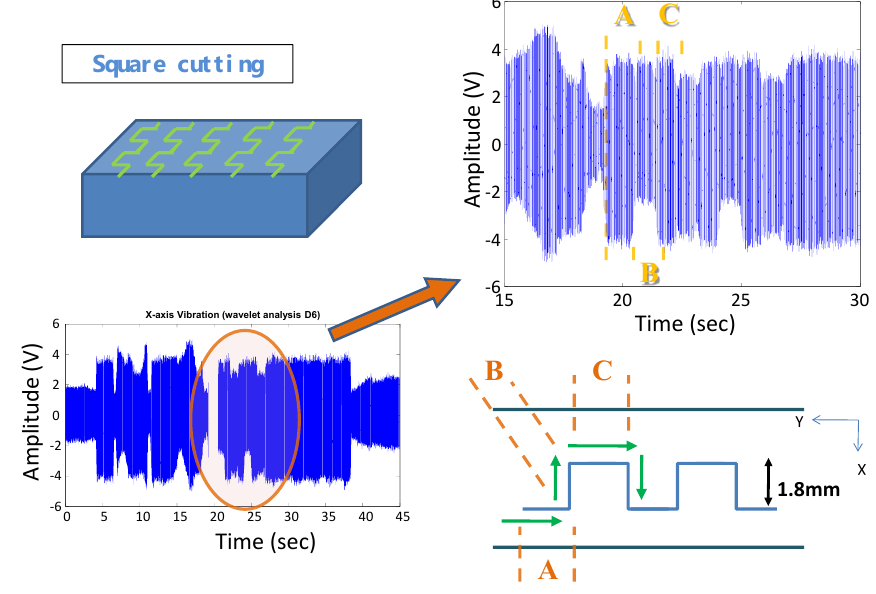
Figure 9. Signal change in square path cutting (sharp tool in x − direction). The AE signals are generated primarily by the strain rate of the material on the work- piece and the tool, as well as the friction on the tool—chip interface. The raw signal of the AE signals collected simultaneously with the vibration signals are shown in Figure 10 for the sharp and worn tool. In contrast with the vibration signal discussed above, no clear energy change in the signal features can be observed in the change in the cutting path. This suggests that the direction change in the cutting path might not significantly affect the AE signal, as its effect on the vibration signals is in all directions.